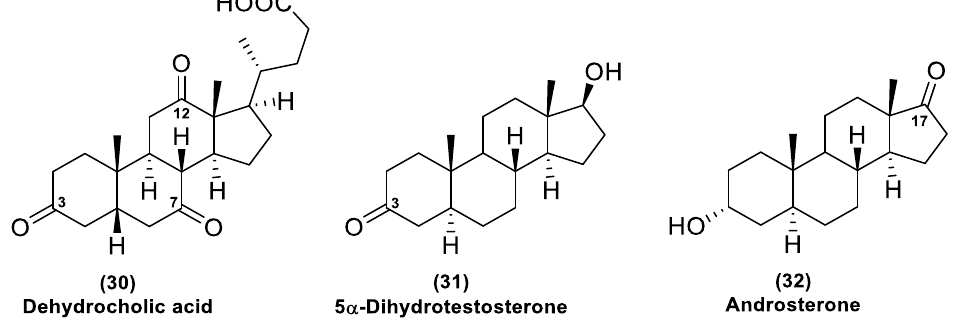
Figure 6. Bile acids and steroidal substrates tested in Is2-SDR-catalyzed reductions. Dehydrocholic acid ( 30 ), with three ketones located at the 3, 7 and 12 positions, was further considered to better define Is2-SDR regio- and stereoselectivity. A small-scale preparative reaction (see experimental details in materials and methods) was conducted using, again, the BmGDH/glucose system for NADP + regeneration and working at pH 8.0 (100 mM PB buffer) to permit good substrate solubility. After assessing the complete conversion of 30 into a more polar product by TLC, a full 1 H- and 13 C-NMR